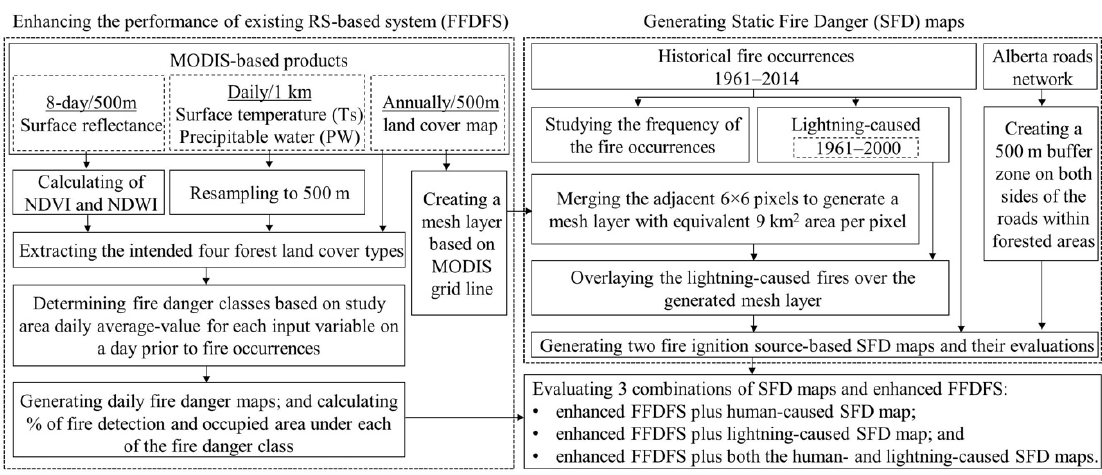
Figure 3. Schematic diagram of the enhanced forest fire danger forecasting system.